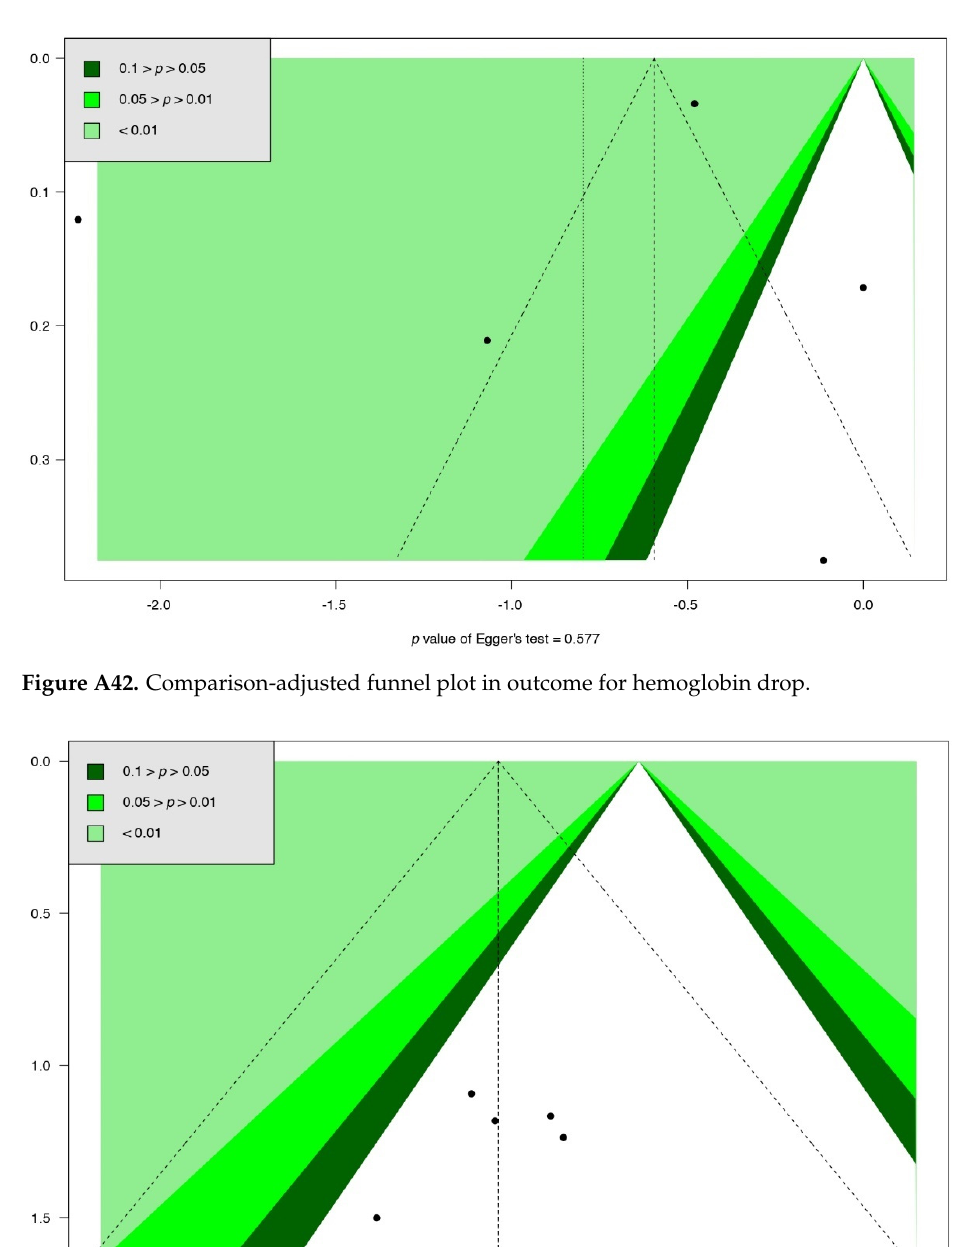
Figure A41. Comparison-adjusted funnel plot in outcome for post-operative fever.